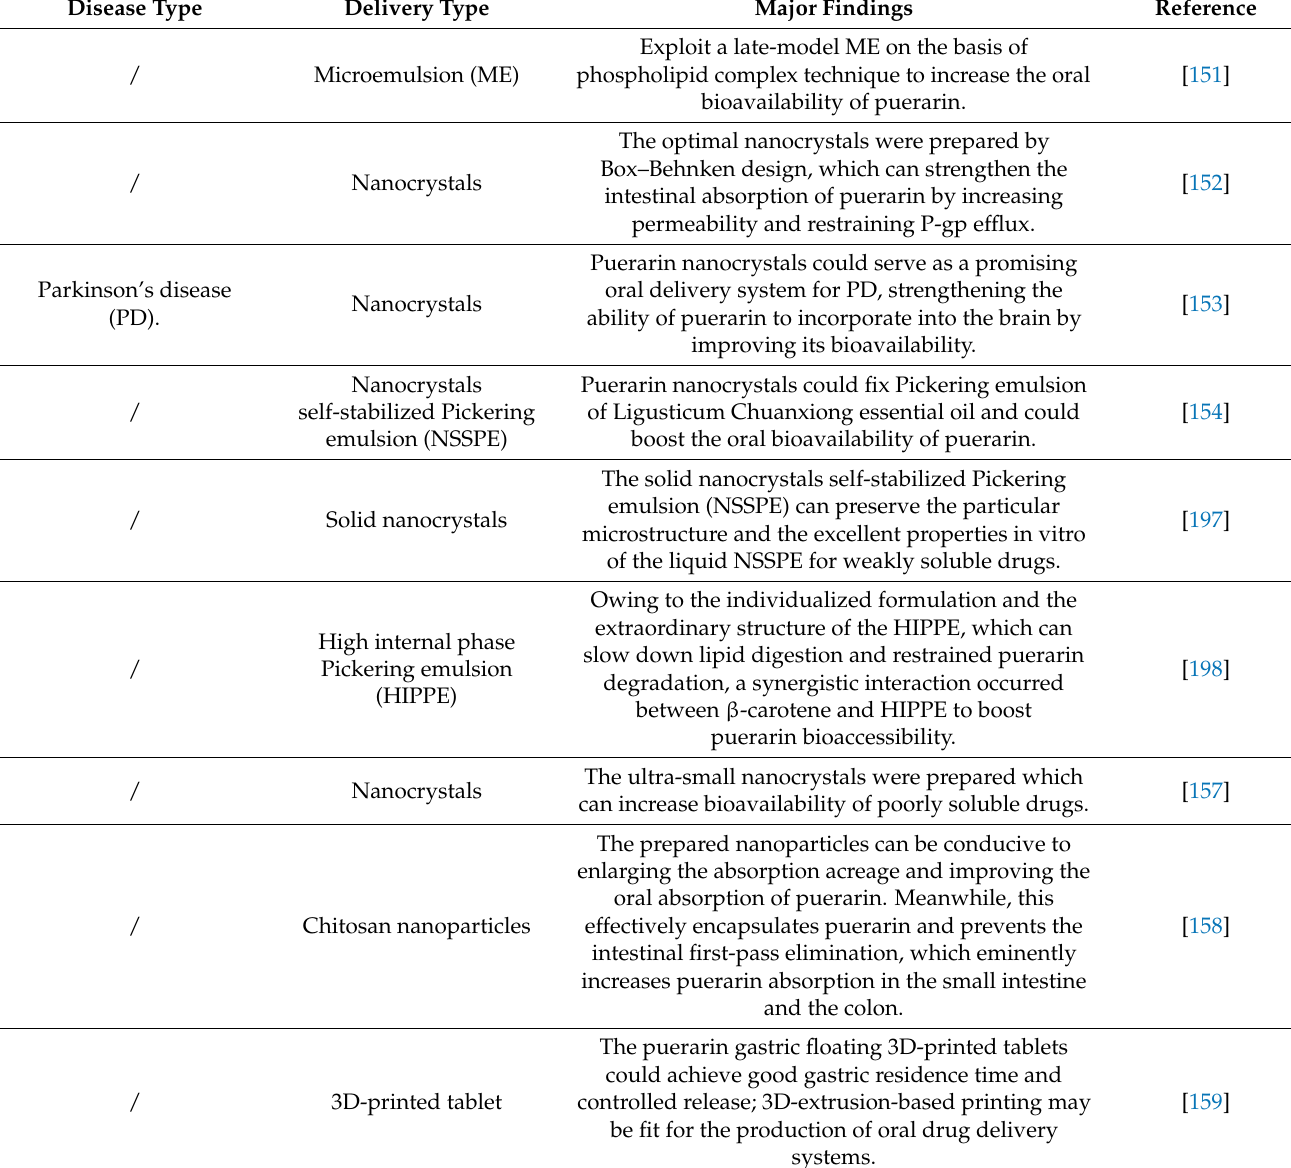
Table 1. Different delivery systems of puerarin for